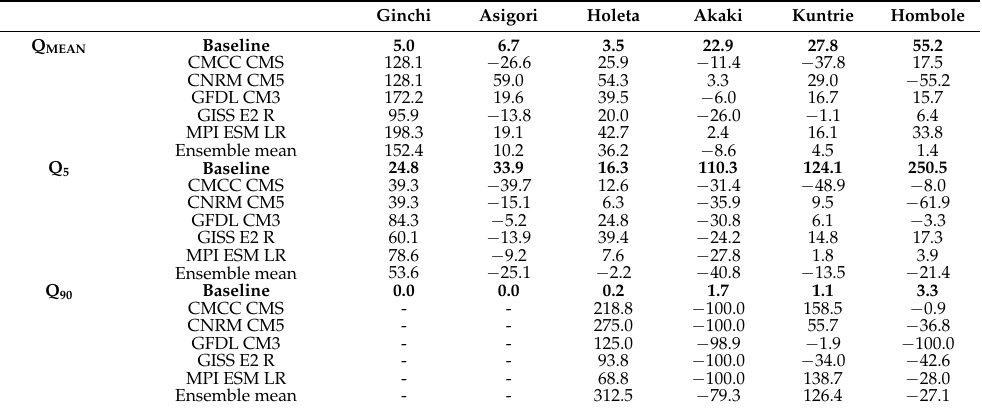
Table 10. Q mean , Q 5 , and Q 90 discharge in m 3 s − 1 for the baseline and change (percent) from the baseline for each GCM and ensemble mean (Minus sign ( − ) indicates declines relative to the baseline).